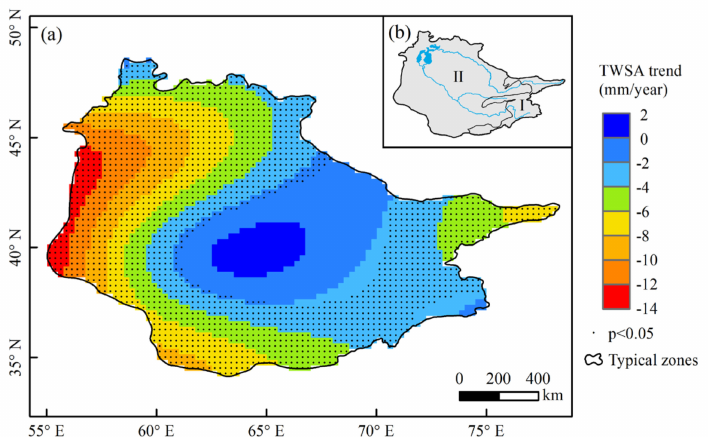
Figure 5. The spatial variation trend in TWSA of the Aral Sea Basin retrieved by GRACE during the period of April 2002 to June 2017 ( a ), and the distribution of the upstream (I) and mid-downstream (II) of the Aral Sea Basin ( b ).